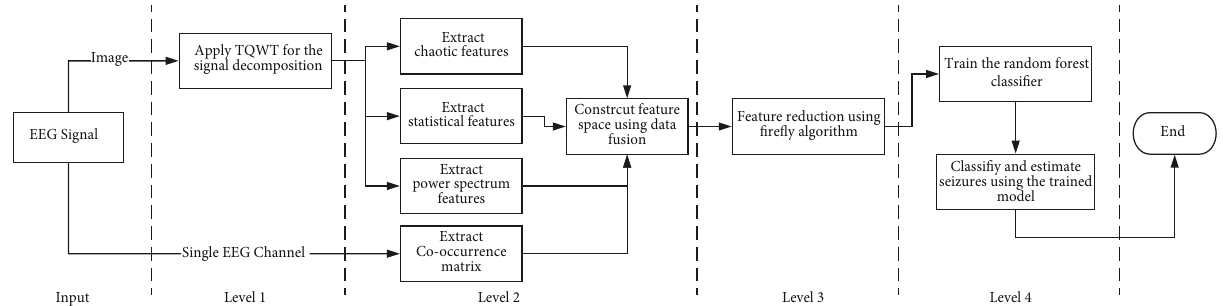
Figure 1: Block diagram of the combinational hybrid system of epilepsy detection from EEG signal with 4 levels of processing.